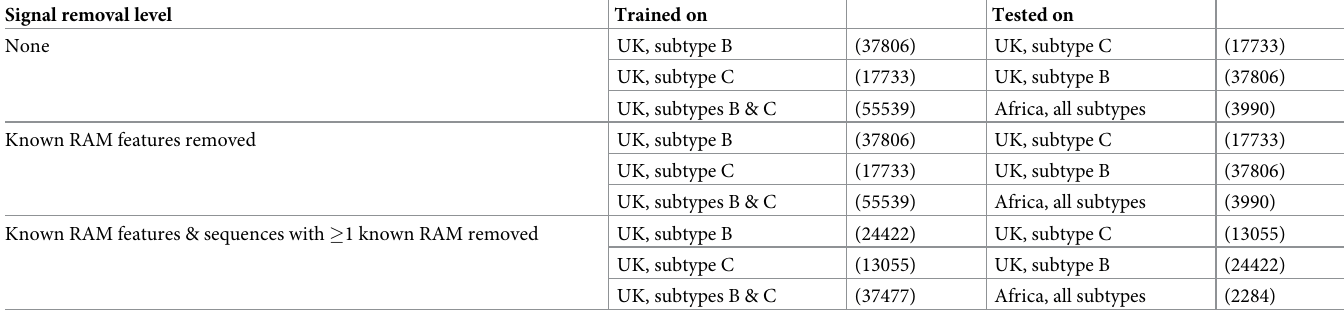
Table 2. All training and testing datasets used during this